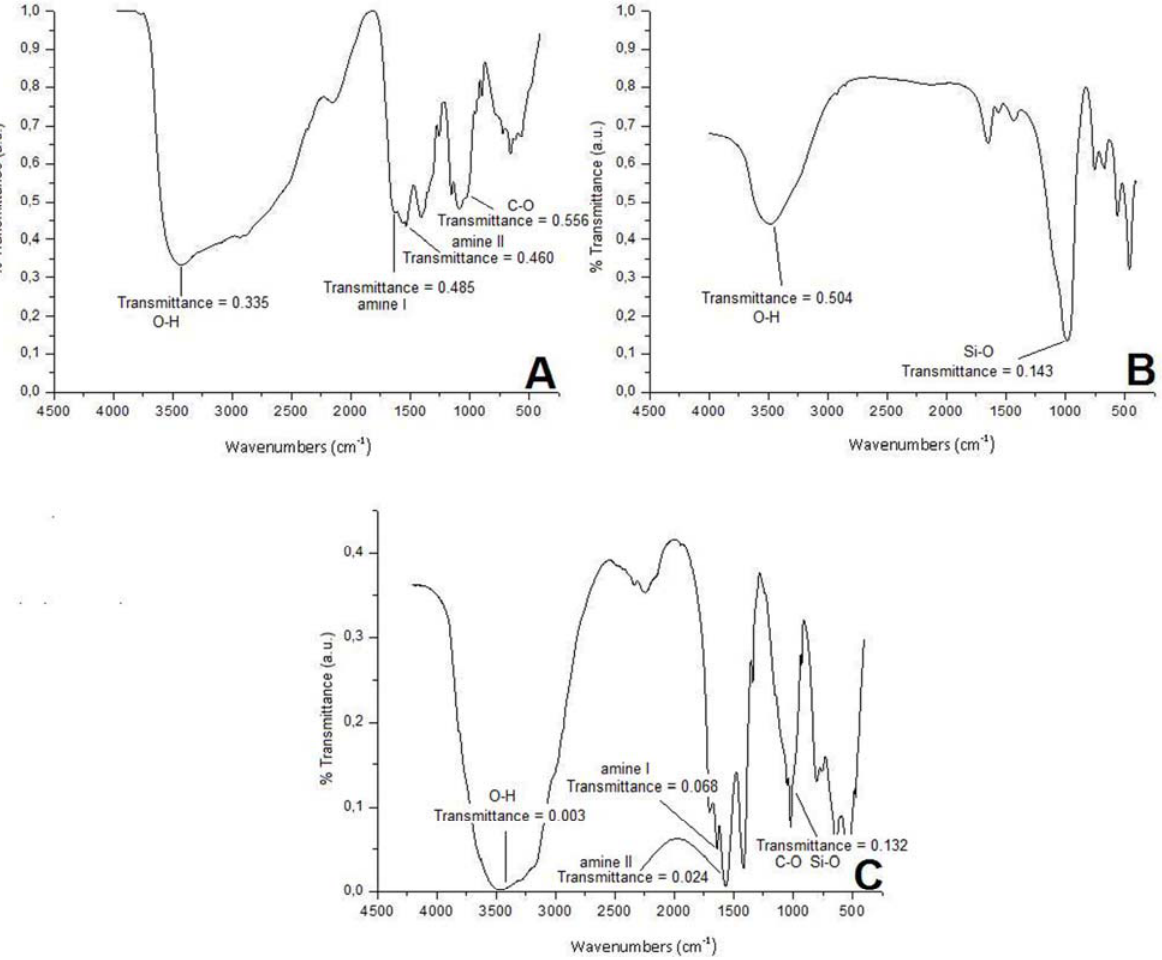
Figure 1. FTIR spectra of chitosan film ( A ), zeolite powder ( B ) and chitosan/zeolite film (1:10 w/w) ( C ).